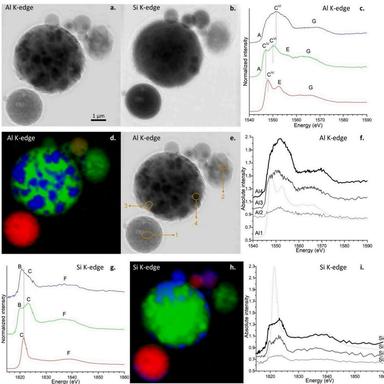
(a) Ptychographic magnitude image of the region of interest (ROI) taken at Al K-edge 1550.5 eV; (b) ptychographic magnitude image of the ROI taken at Si Kedge 1821.5 eV; (c) Al K-edge XANES spectra with normalized intensity extracted from K-Means clustering analysis; (d) Al RGB overlay map plotted with XANES spectra at Al K-edge obtained from (c) using the singular value decomposition method, red, green, blue regions were plotted with the red, green, and blue spectra in (c), respectively; (e) selected regio